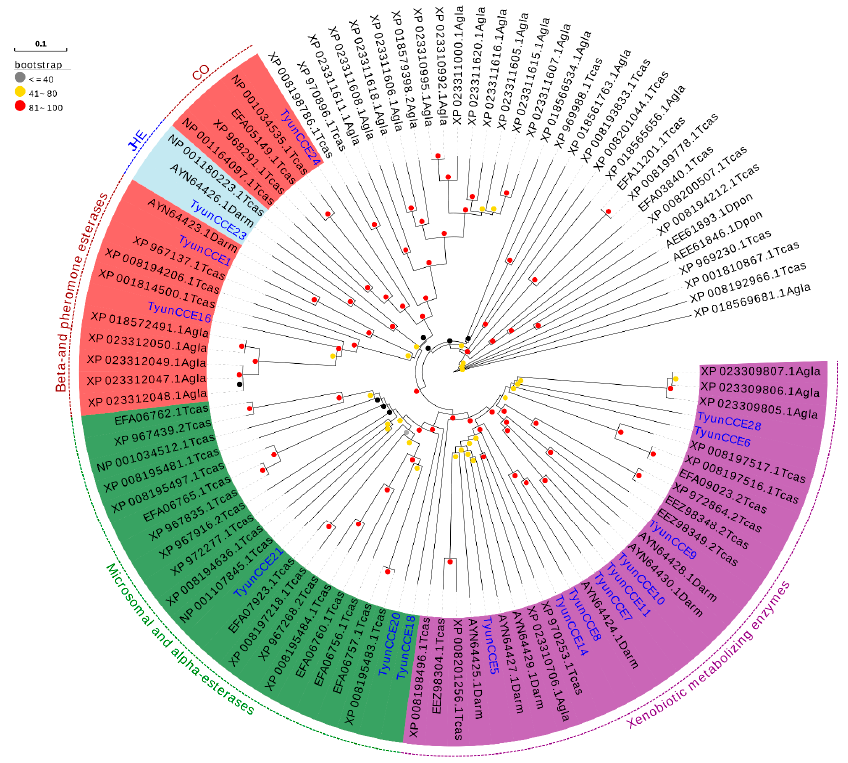
Figure 5. Neighbor-joining tree of candidate CCEs. Bootstrap values after 1000 replications. Dpon, Dendroctonus ponderosae ; Darm, Dendroctonus armandi ; Agla, Anoplophora glabripennis ; Tcas, Tribolium castaneum ; Tyun, Tomicus yunnanensis .